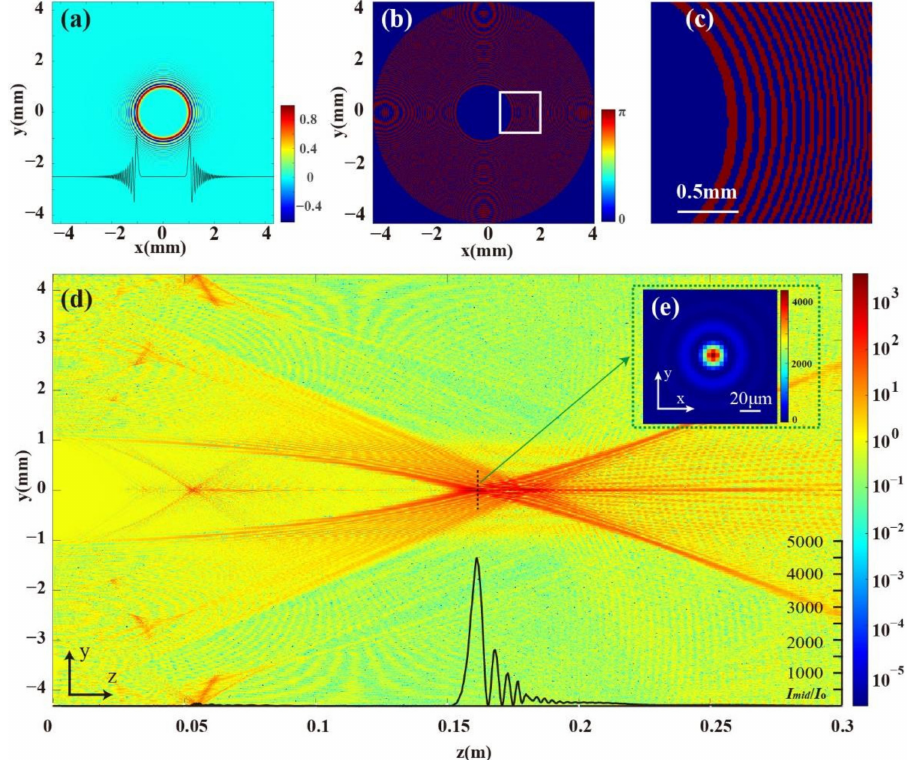
Figure 1. Propagation properties of e iBp ( x , y ) . ( a ) The initial electric field of a circular Airy beam. ( b ) The Bp phase map. ( c ) Partial detail of ( b ). ( d ) The side view of the beam propagation at the y – z plane. ( e ) The relative intensity distribution of the focal